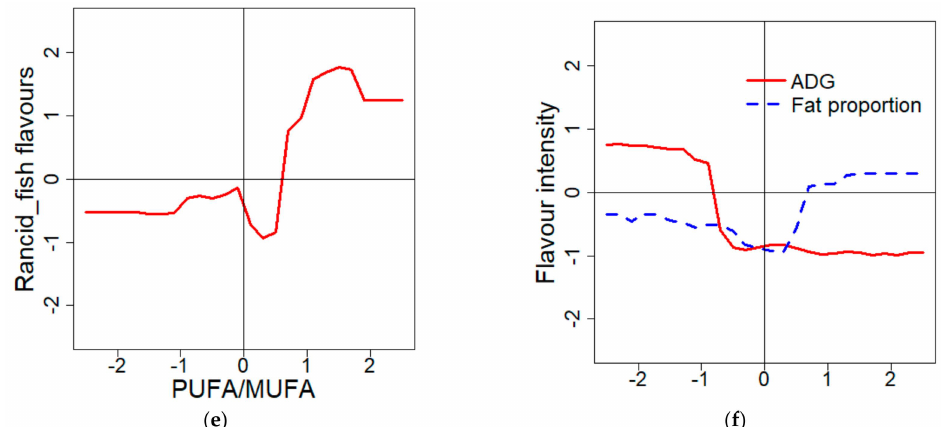
Figure 3. ( a ) Prediction of the fat proportion and the lipid content versus the ADG (average daily gain) variations; ( b ) Prediction of the PUFA / MUFA (polyunsaturated fatty acid / monounsaturated fatty acid)ratio versus the fat proportion variations; ( c ) Prediction of the n -6 / n -3 ratio versus the FCR (feed conversion ratio) and fat proportion variations; ( d ) Prediction of the tenderness versus the fat development variation; ( e ) Prediction of the unwanted rancid-fish flavor versus the PUFA / MUFA ratio variations; ( f ) Prediction of the flavor intensity versus the ADG and the fat proportion variations.